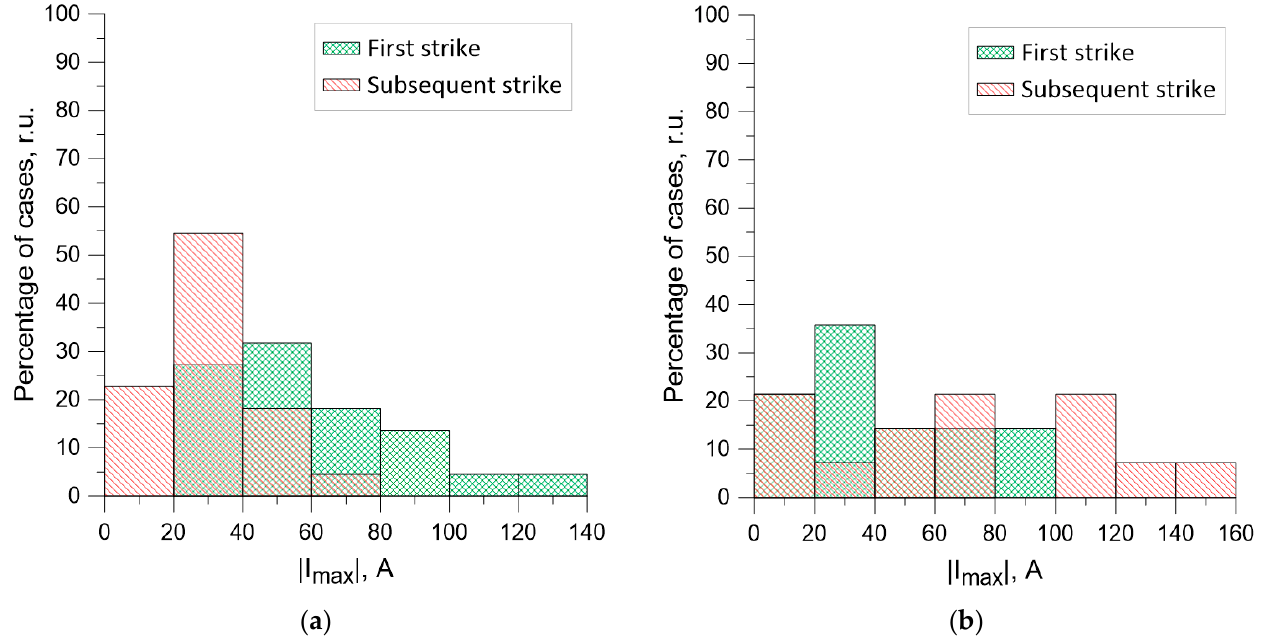
Figure 14. Distribution of current pulse amplitude values of the first and repeated discharges at negative polarity of artificial thunderstorm cells ( a ) and at positive polarity of artificial thunderstorm cells ( b ).